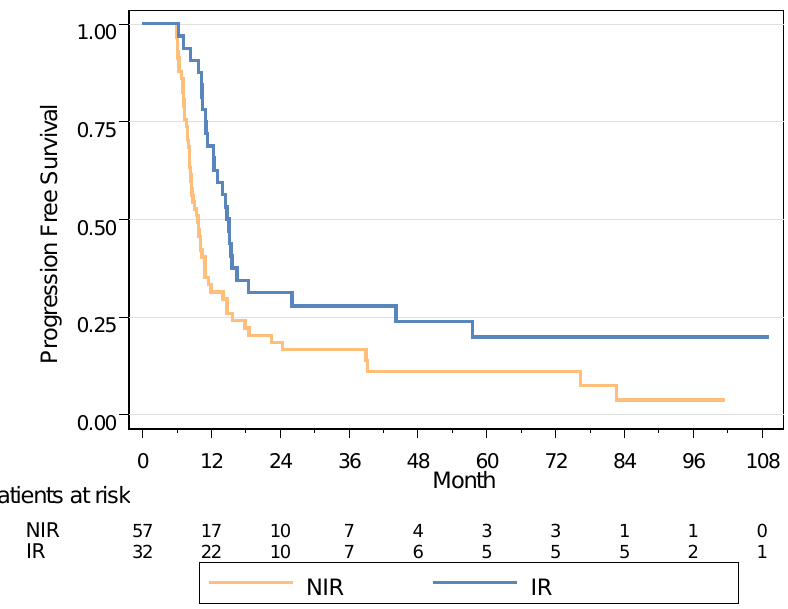
Figure 2. Progression-free survival in landmark analysis at 6 months for NIR (no irradiation) vs. IR group (radiotherapy within 6 months).